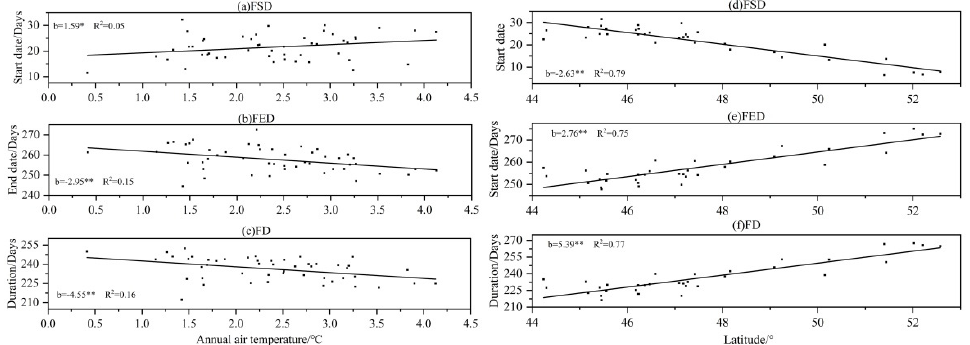
Figure 5. Correlation analysis of the key variables with temperature ( a – c ) and latitude ( d – f ) (** indicates reaching a significance level of α = 0.01, * indicates reaching a significance level of α = 0.05).